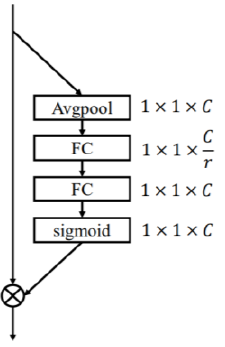
Figure 4. The attention module.